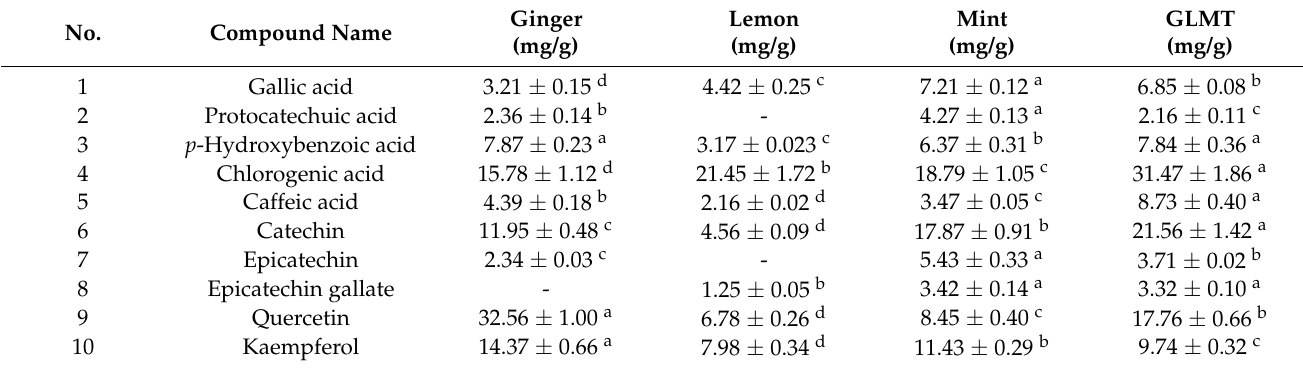
Table 4. Quantification of phenolic compounds in ginger, lemon, mint and